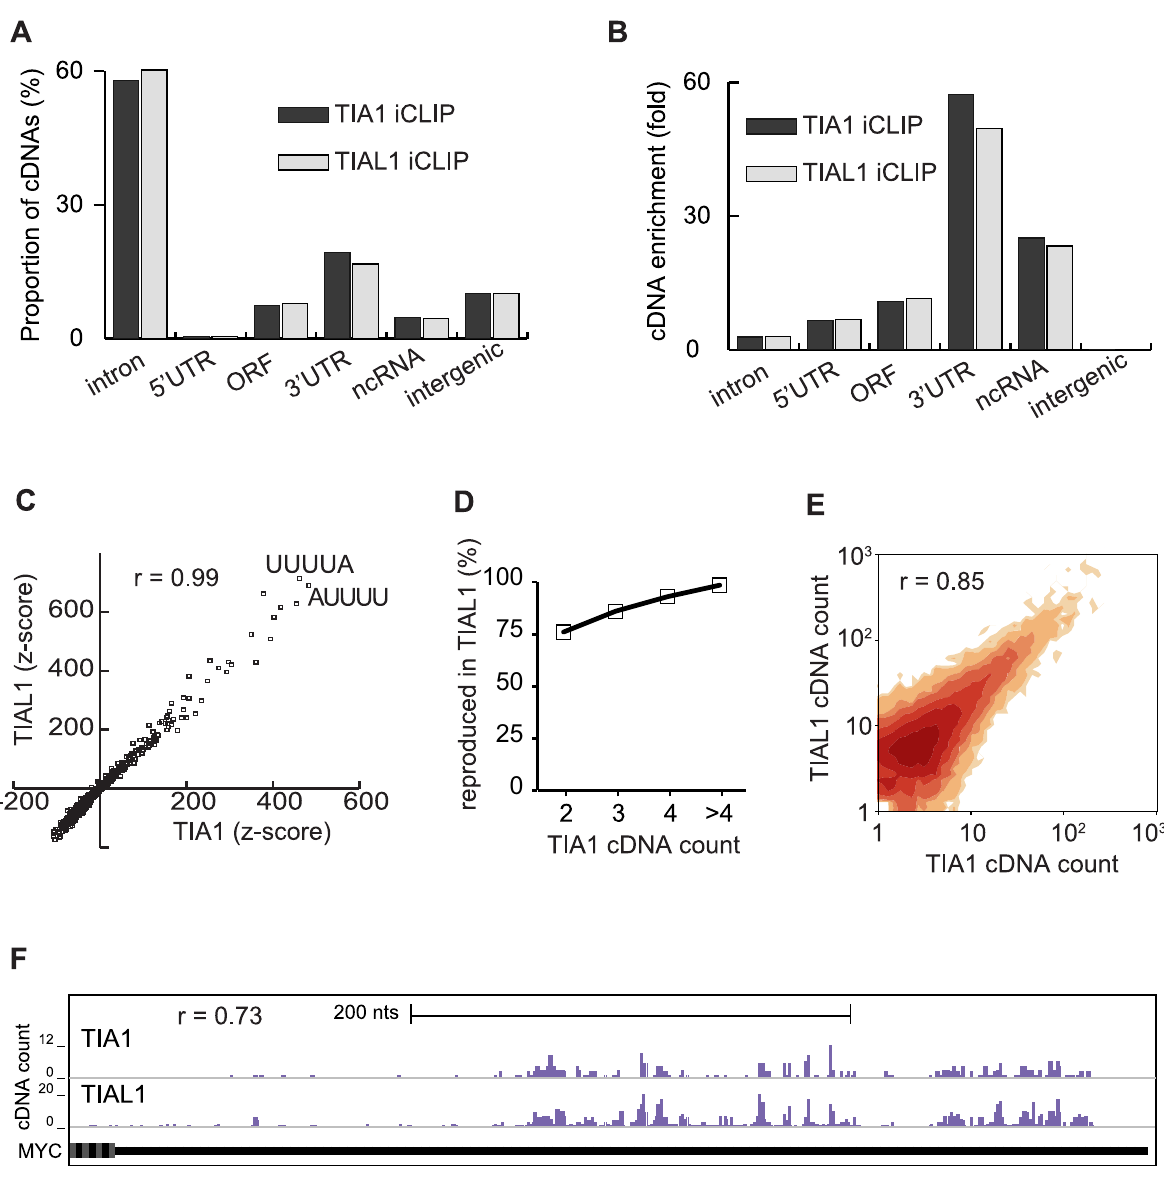
Figure 2. TIA1 and TIAL1 crosslink to the same positions in human RNAs. (A) The percentage of cDNAs from TIA1 and TIAL1 iCLIP that mapped to different types of RNAs. (B) The fold enrichment of average cDNA density from TIA1 and TIAL1 iCLIP in different types of RNAs relative to the average cDNA density in the whole genome. (C) Pentamer z scores at the 21 nt sequence surrounding crosslink sites ( 2 10 nt to + 10 nt) are shown for TIA1 and TIAL1 iCLIP. The sequences of the two most enriched pentamers and the Pearson correlation coefficient ( r ) between the TIA1 and TIAL1 z scores are shown. (D) Reproducibility of TIA1 and TIAL1 crosslink clusters. Percentage of crosslink clusters with a given cDNA count in TIA1 iCLIP that were also identified in TIAL1 iCLIP is shown. (E) Contour plot comparing TIA1 and TIAL1 cDNA counts in the 46,970 crosslink clusters. The darkness of contours increases with the number of clusters. The Pearson correlation coefficient ( r ) between the TIA1 and TIAL1 cDNA counts in the clusters is shown. (F) Crosslink sites of TIA1 and TIAL1 in the 3 9 UTR of the MYC gene. The bar graph shows the number of cDNAs that identified each crosslink site. The Pearson correlation coefficient ( r ) between the TIA1 and TIAL1 cDNA counts at individual nucleotides is shown. doi:10.1371/journal.pbio.1000530.g002 Figure 3B) predicted silenced alternative exon inclusion if TIA crosslink clusters were absent in the region a . This predicted 1,962 alternative cassette exons as silenced by TIA proteins.